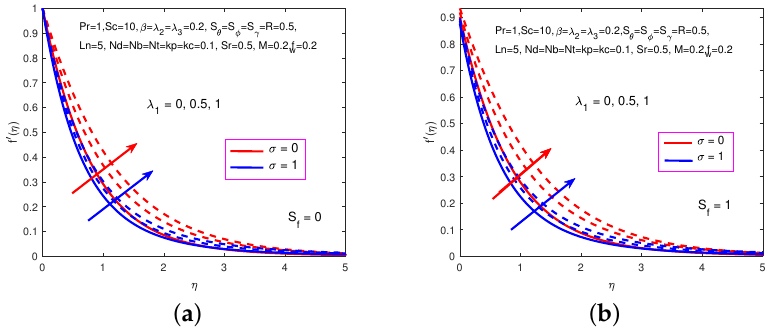
Figure 3. Influence of λ 1 and σ on f (cid:48) . ( a ) No hydrodynamic slip. ( b ) With hydrodynamic